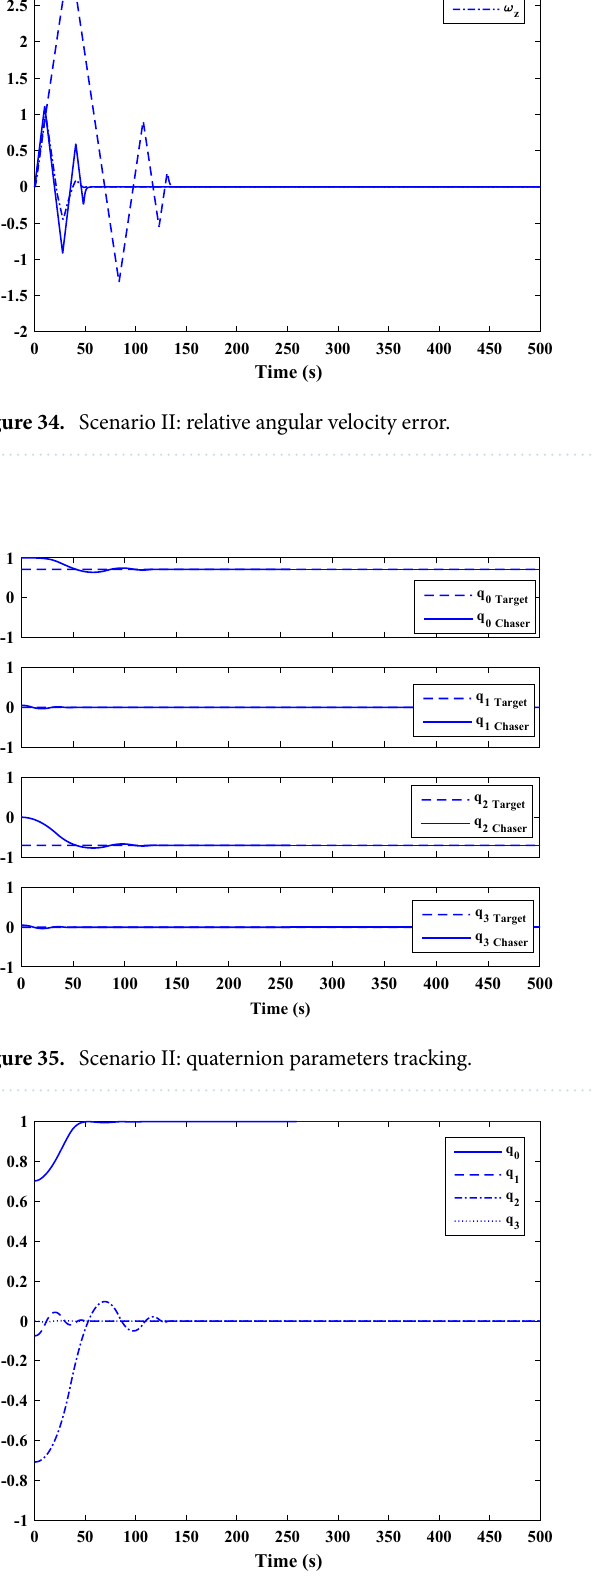
Figure 36. Scenario II: relative quaternion parameters